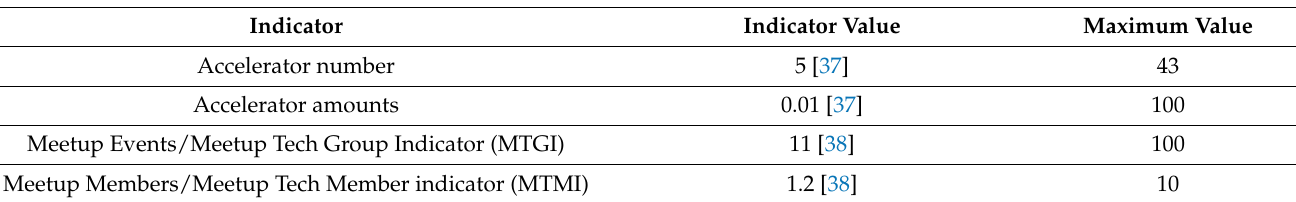
Table 7. The components of networking and supporting in the digital dimension—the startup phase of an enterprise (the table refers to the Republic of Serbia and was made in the likeness of the EIDES report).